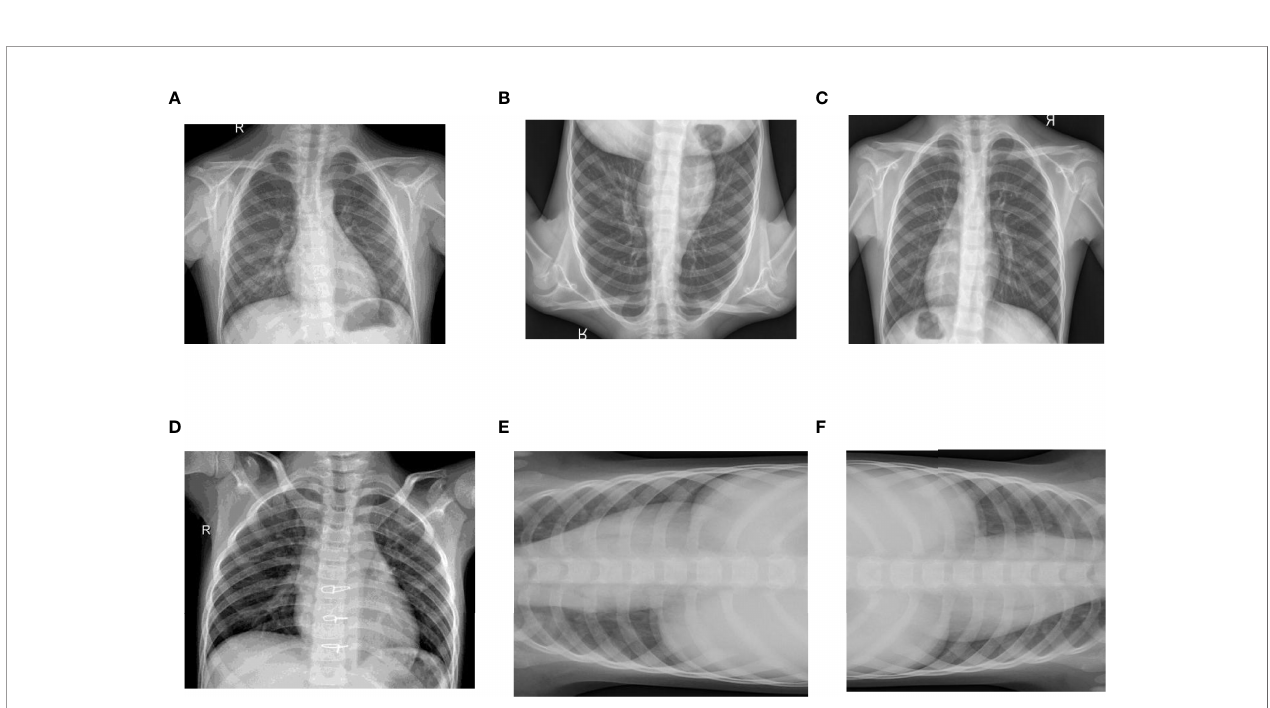
FIGURE 4 | Data Augmentation of Images: (A) Original Healthy Chest X-ray, (B) Healthy Chest X-ray Flipped Vertically, (C) Healthy Chest X-ray Flipped Horizontally, (D) Original Pneumonic Chest X-ray, (E) Pneumonic Chest X-ray rotated 90 degrees left and (F) Pneumonic Chest X-ray rotated 90 degrees